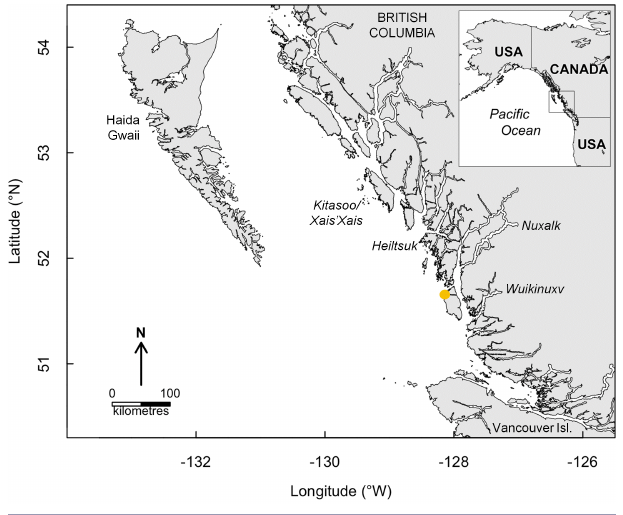
Fig. 1 . Located along Canada’s west coast is the Great Bear Rainforest, an area in British Columbia (BC) encompassing northern Vancouver Island, BC’s Central Coast, North Coast, and Haida Gwaii. The Central Coast of BC has been home to four Indigenous communities, the Heiltsuk, Kitasoo/Xais’Xais, Nuxalk, and Wuikinuxv Nations, for at least 13,000 years. Research showcased in this Special Feature was coproduced by scientists, students, and Indigenous collaborators in partnership with the Hakai Institute’s (yellow circle) research and educational